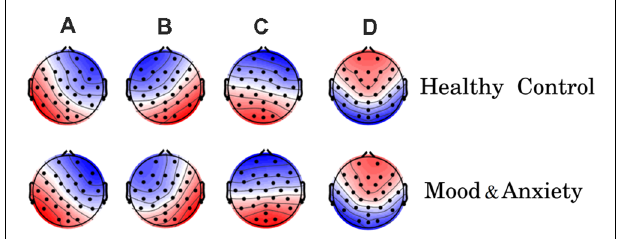
FIGURE 1 | Electroencephalography-microstate (EEG-ms) topographies for both groups [healthy control (HC) group top row, mood and anxiety disorders (MA) group lower row]. The obtained EEG-ms topologies are similar to those reported previously in the literature.